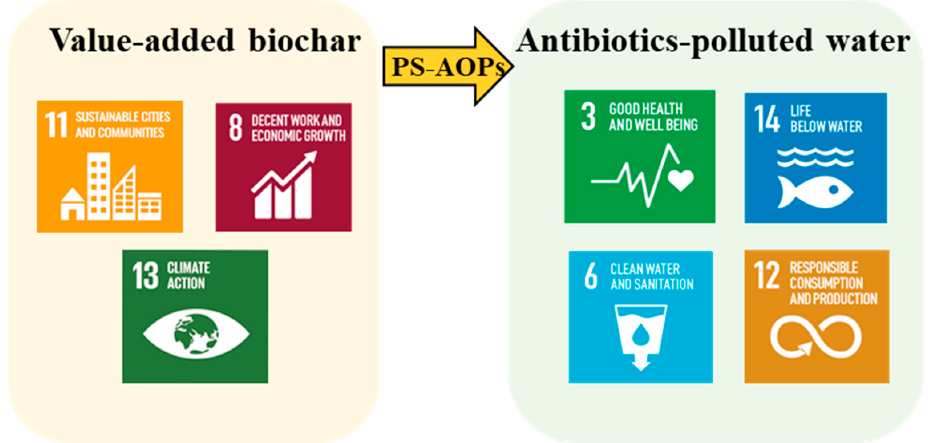
Figure 4. Feasible achievement of the Sustainable Development Goals (SDGs) through the application of the biochar/persulfate (PS) system for the removal of antibiotics.